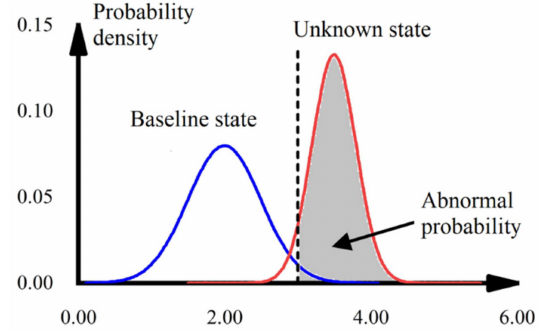
Figure 5. Schematic diagram of damage probability calculation.